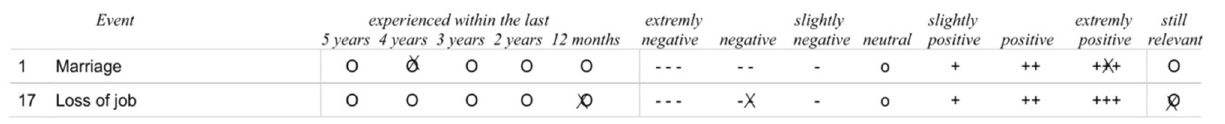
fast did the last 5 years pass by for you personally?”),